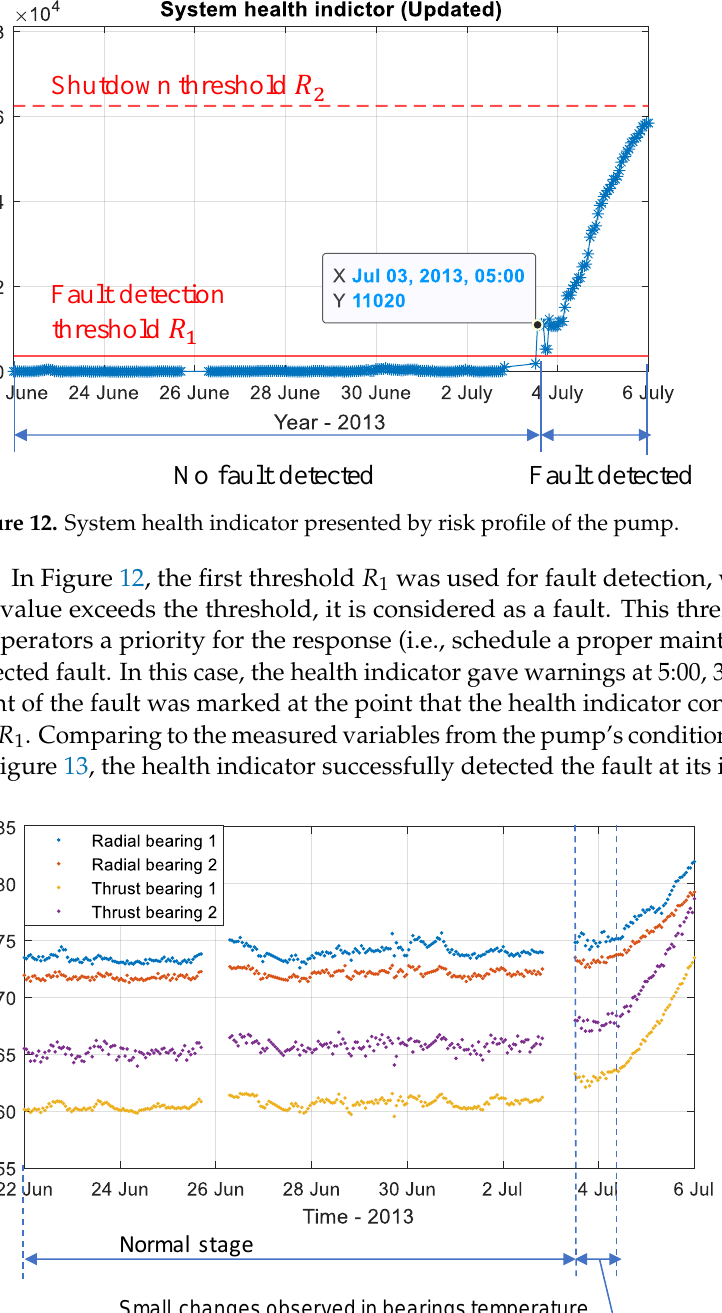
Figure 11. Consequence of a fault occurring in the pump system updated by bearing-related fault.